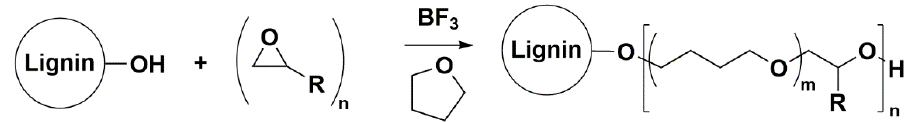
Scheme 1. Lignin-based polyols (LBPs) synthesis by cationic ring opening polymerization (CROP) reaction of oxiranes in THF in the presence of